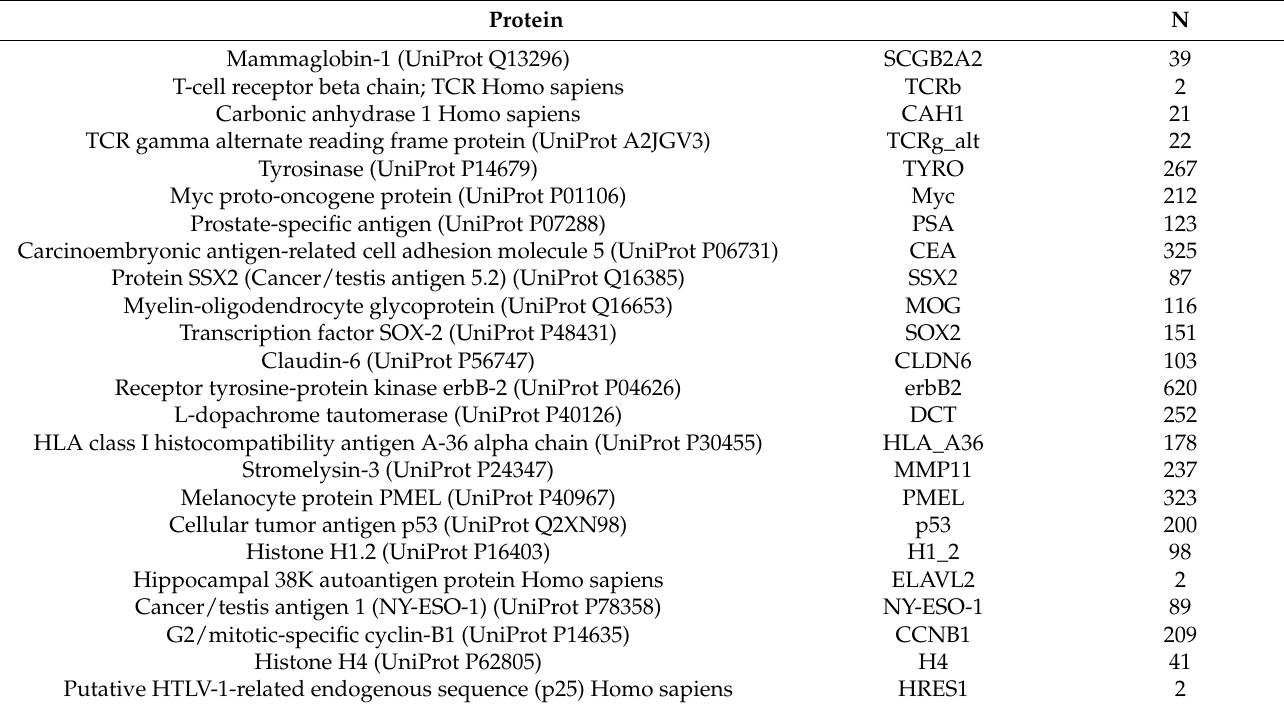
Table 2. Tumor antigens included in the microarray and the number of peptides. The antigens are ordered in an ascending order relative to the mean IgM